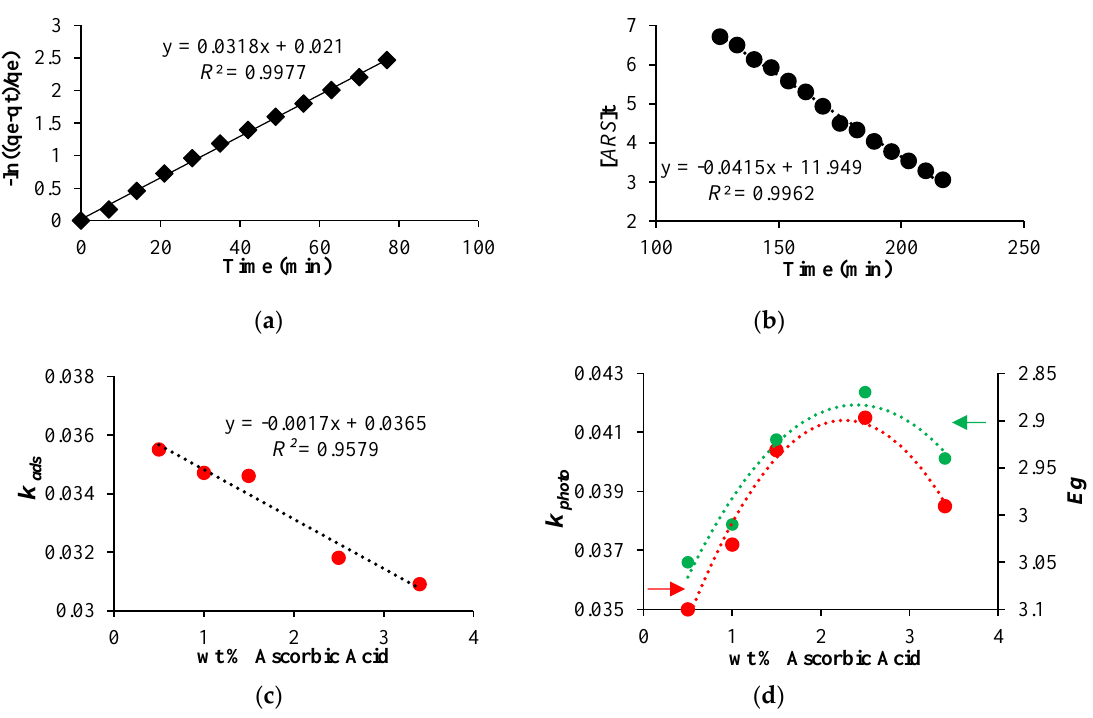
Figure 8. ( a ) Pseudo first order adsorption kinetic; ( b ) zero order photodegradation kinetic by using [PP@AA-TiO 2 ] A containing 2.5 wt %; ( c ) correlation between 𝑘 𝑎𝑑𝑠 and AA wt %; ( d ) correlations between the 𝑘 𝑝ℎ𝑜𝑡𝑜 and 𝐸 𝑔 vs. AA wt %.